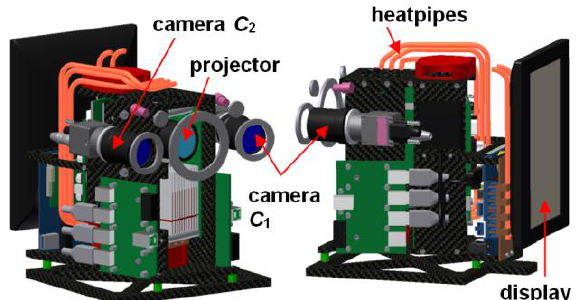
Figure 2. Construction drawing, two